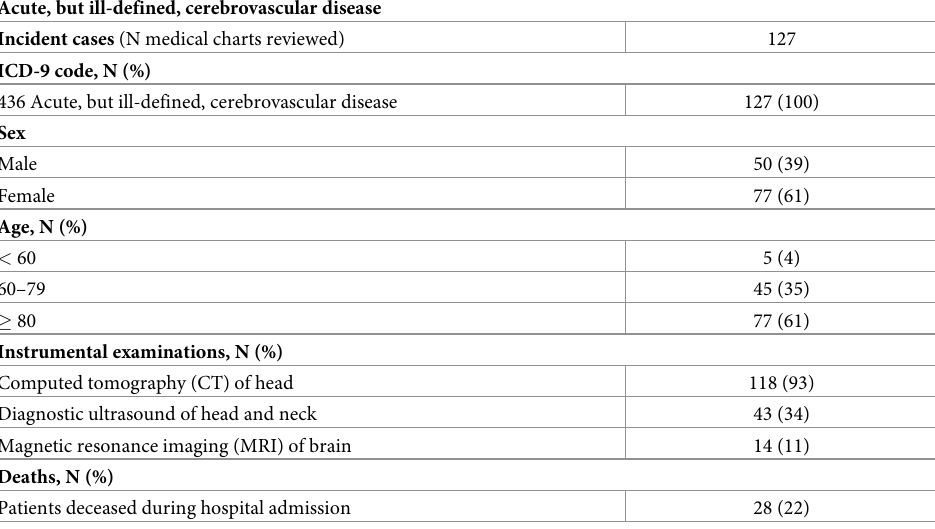
Table 7. Characteristics of patients with acute, but ill-defined, cerebrovascular disease who were identified in the Regional Administrative Database of Umbria. Acute, but ill-defined, cerebrovascular disease Incident cases (N medical charts reviewed)